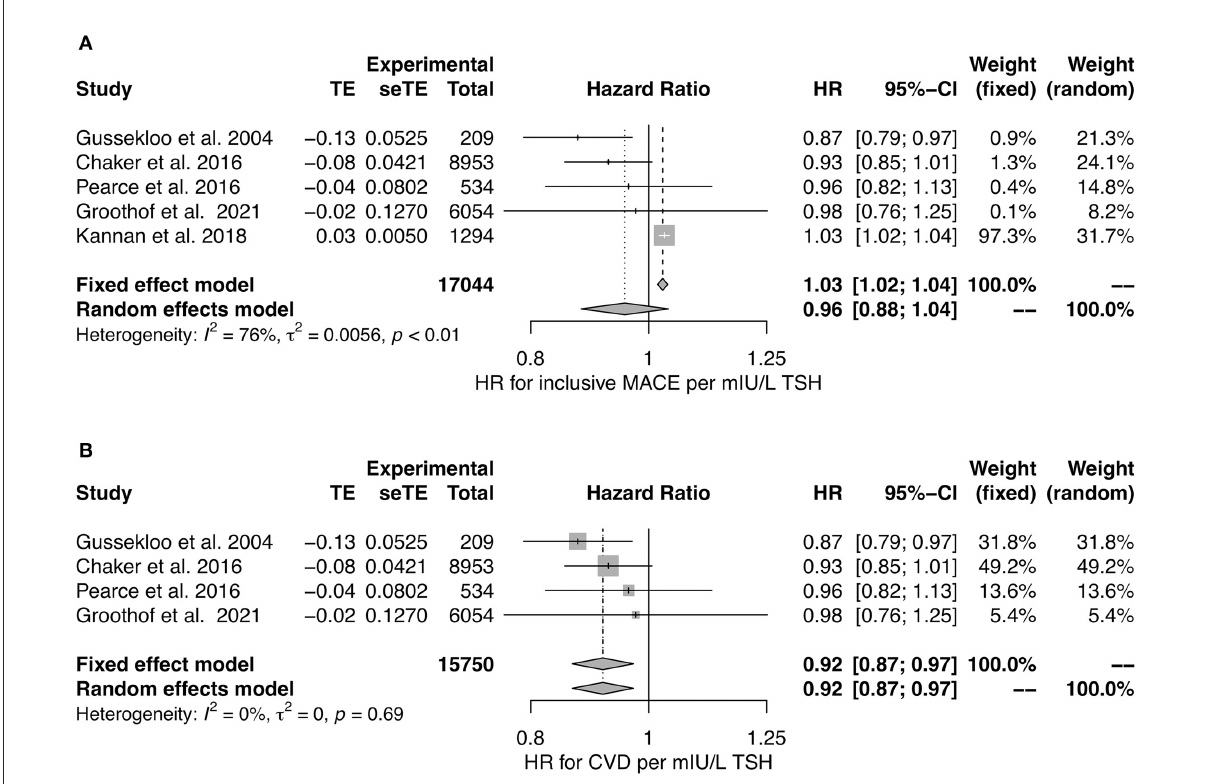
FIGURE6 Hazard ratio for major cardiovascular events (A) and cardiovascular death (B) in relation to TSH concentration (36, 39, 120, 129, 131).